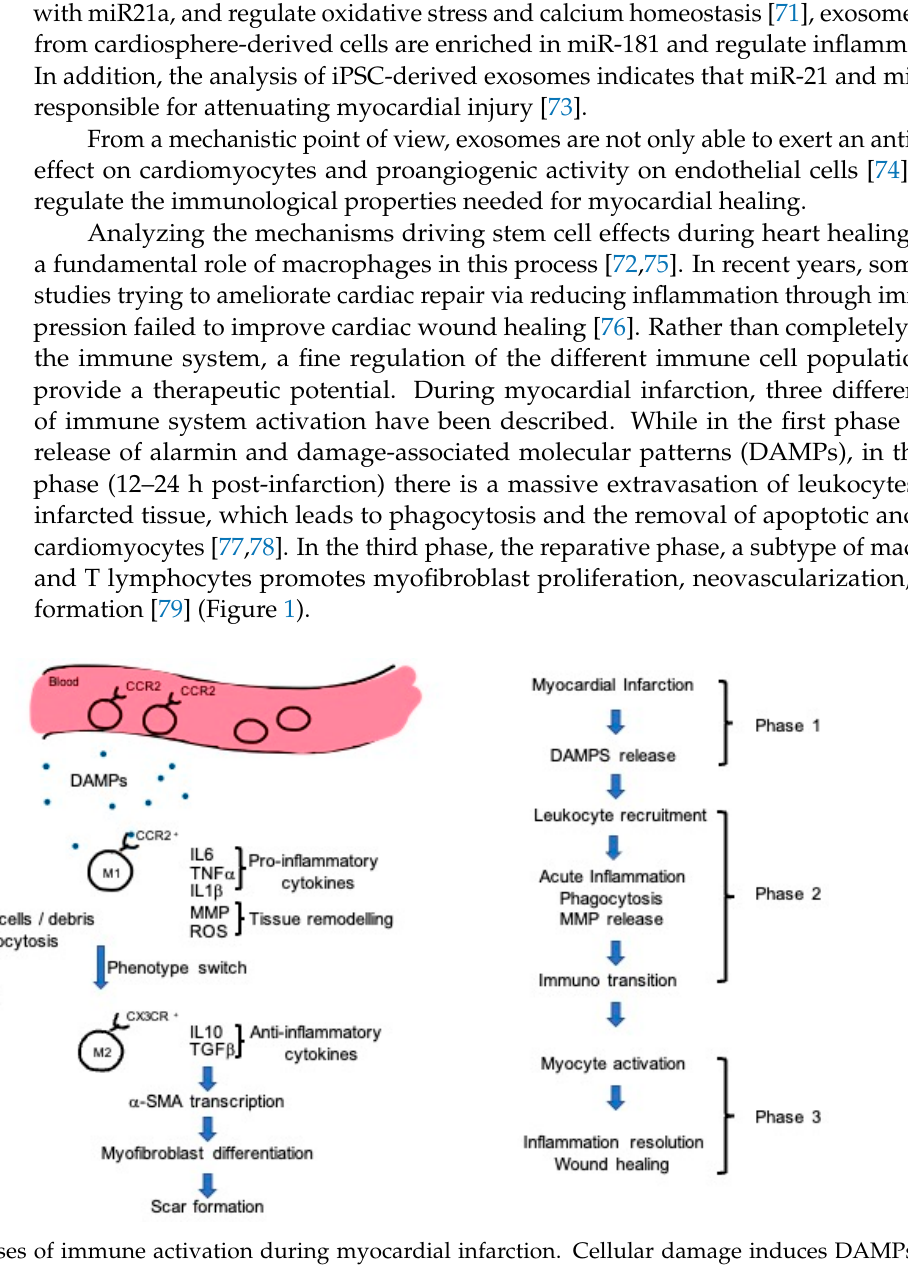
Figure 1. Different phases of immune activation during myocardial infarction. Cellular damage induces DAMPs and alarmin release, which lead to leukocyte infiltration. Once extravasated, macrophages—in particular the M1 subtype— release proinflammatory cytokines and metalloproteases (MMPs), which induce extracellular matrix remodeling. Cellular and debris phagocytosis influence macrophage phenotype switch. M2 subtype macrophages display an anti-inflammatory action, releasing IL-10 and TGF- β . This cytokine activates α -SMA transcription in fibroblasts that could differentiate in myofibroblasts and contribute to scar